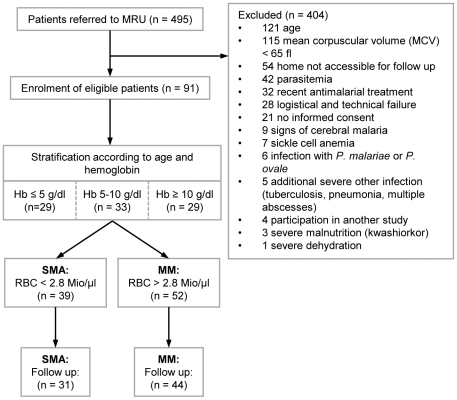
Study-flow chart.